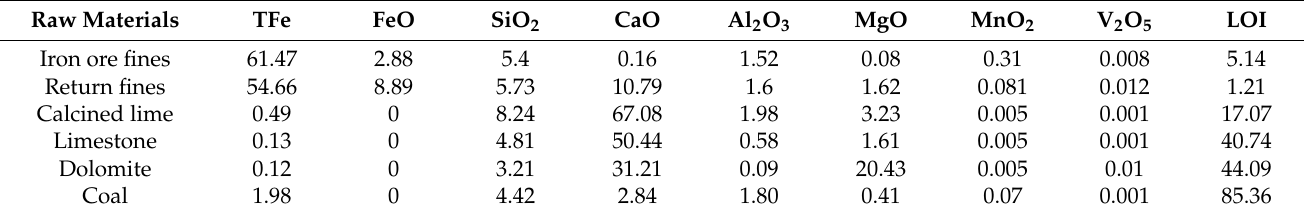
Table 2. Chemical composition of raw materials/wt%.